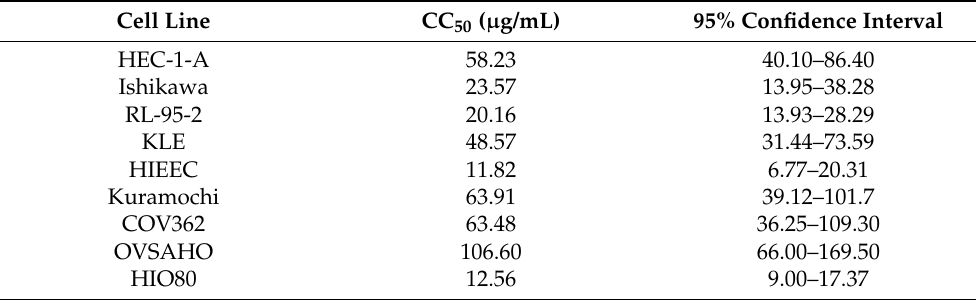
Figure 3. Real-time evaluation of the effects of Cimicifuga racemosa on KLE cell proliferation. Mean values of two independent experiments are shown.